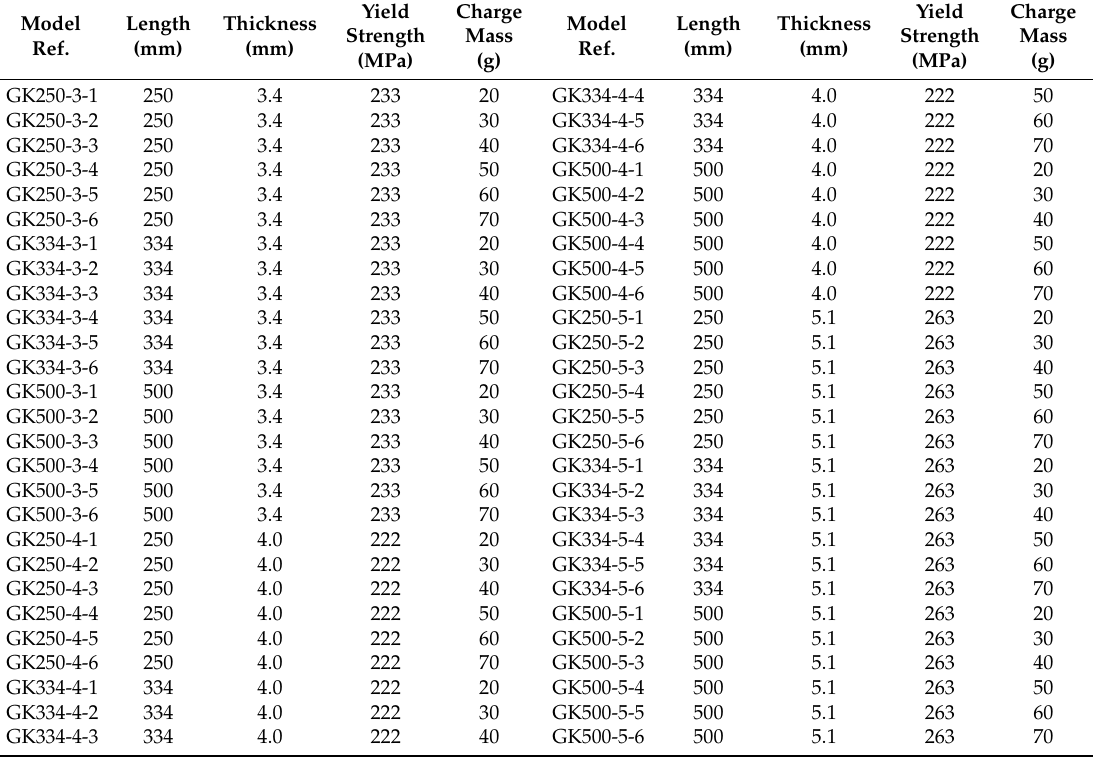
Table 2. Dimensions of the containers and loading conditions in the simulations. Model